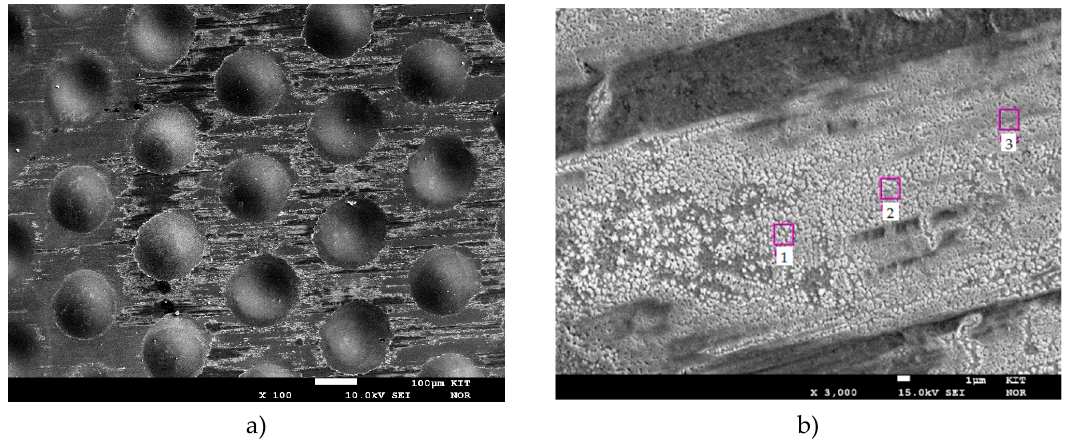
Figure 7. Microprobe images of the membrane surface after permeation tests: ( a ) 100 times enlarged; ( b ) 3000 times enlarged with marked analysis points, where iron is found.